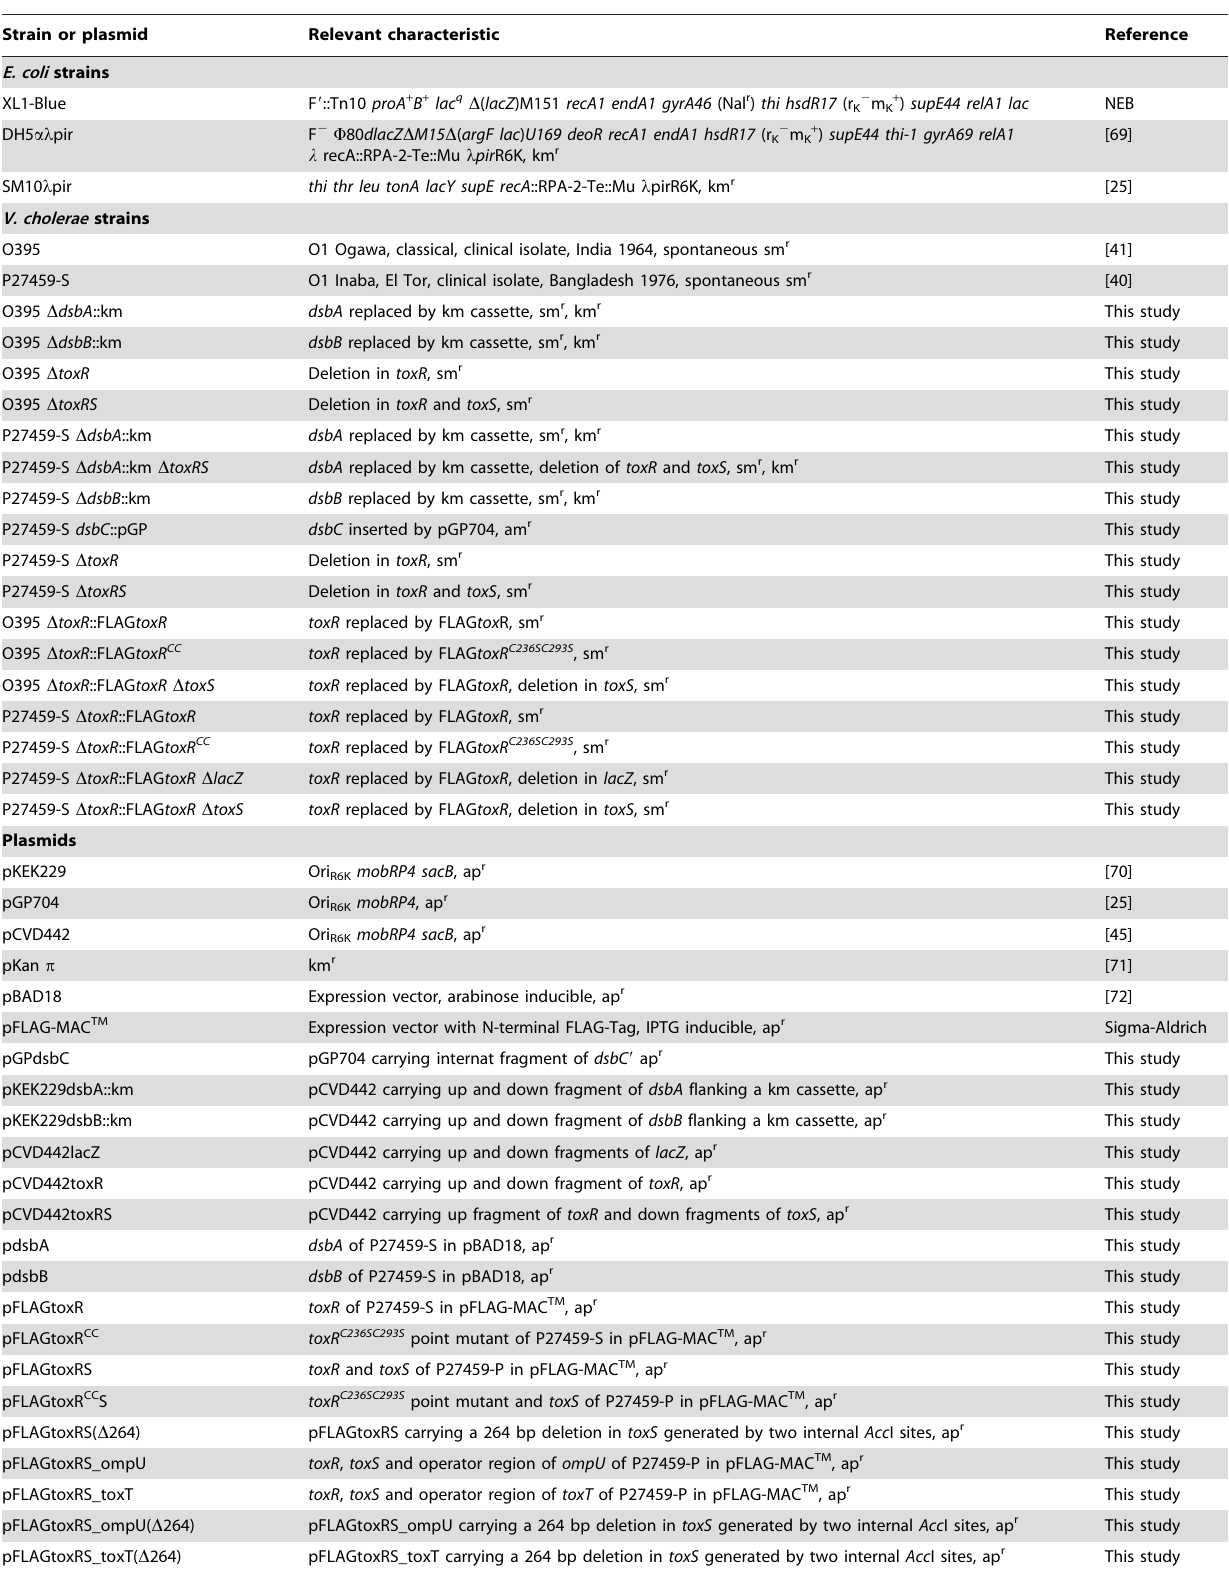
Table 1. Bacteria strains and plasmids used in this study.